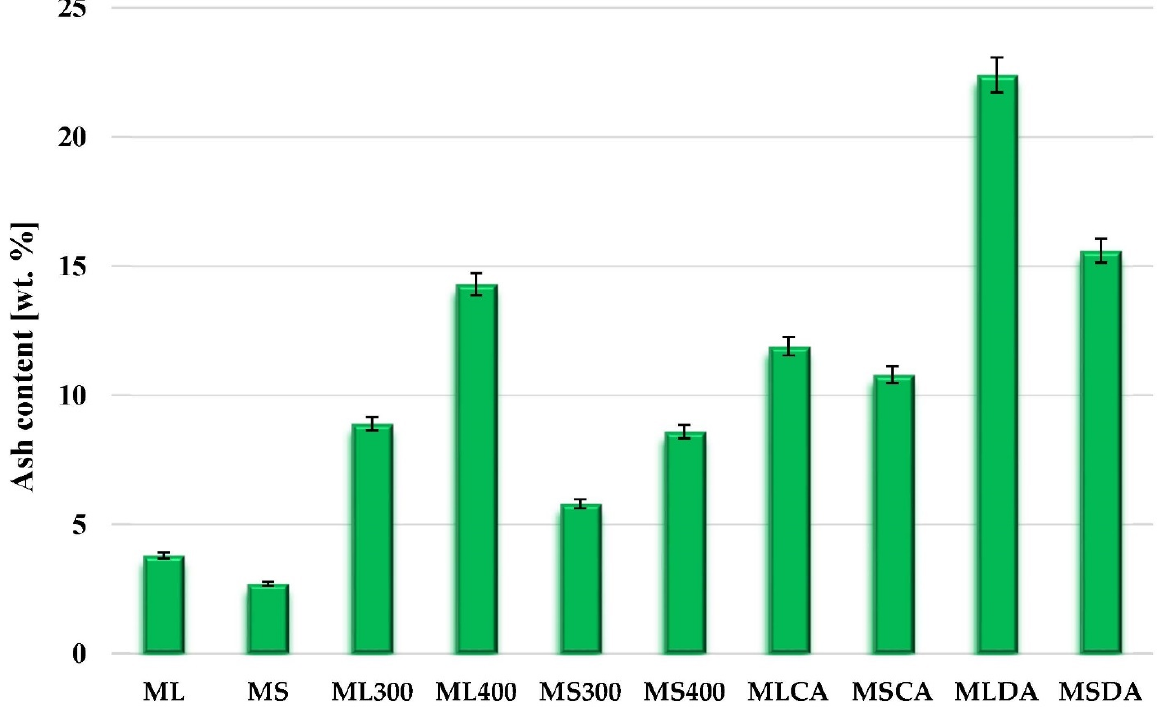
Figure 1. Ash content for the precursors (ML and MS), biochars (ML300, ML400, MS300 and MS400) as well as activated biocarbons obtained via chemical activation (MLCA and MSCA) or physical activation (MLDA and MSDA). Table 1. Elemental composition of the precursors, biochars and activated biocarbons.